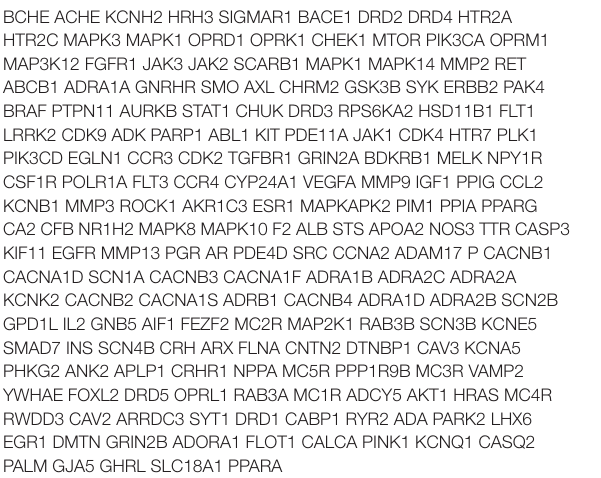
TABLE 4 | 109 core genes and their interaction.